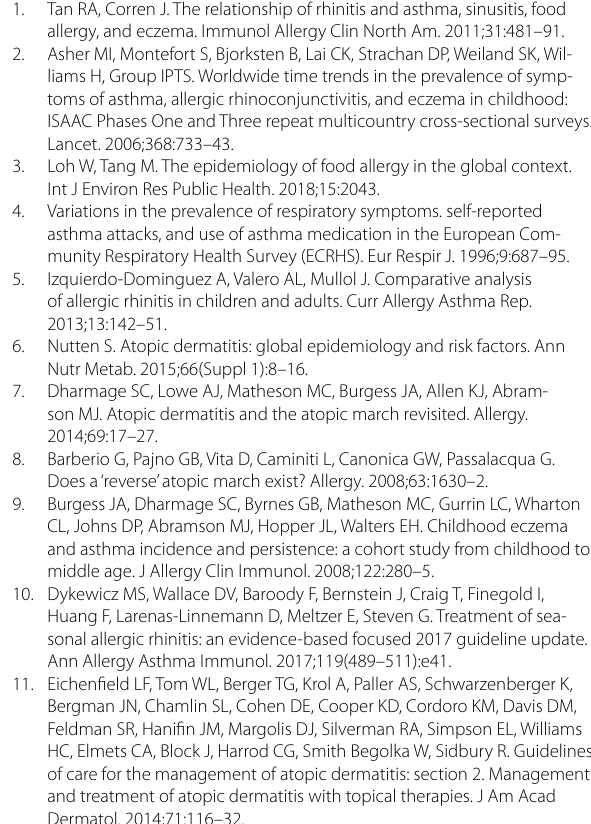
Additional file 1: Table S1. Atopy-related genes from the Human Gene Mutation